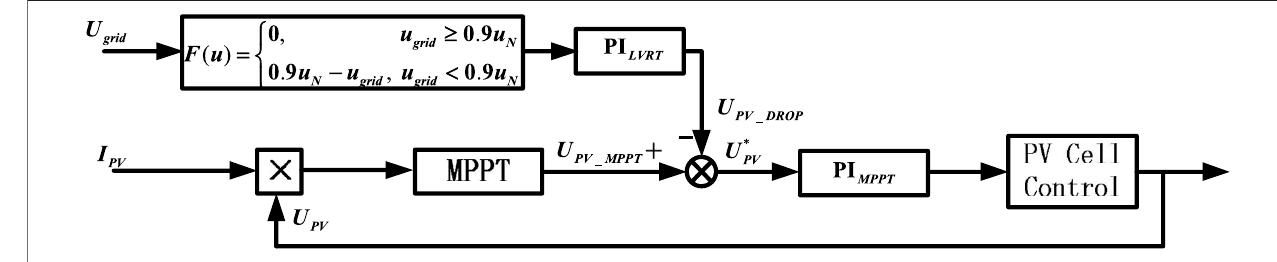
FIGURE 2 | Control strategy of adaptive maximum power